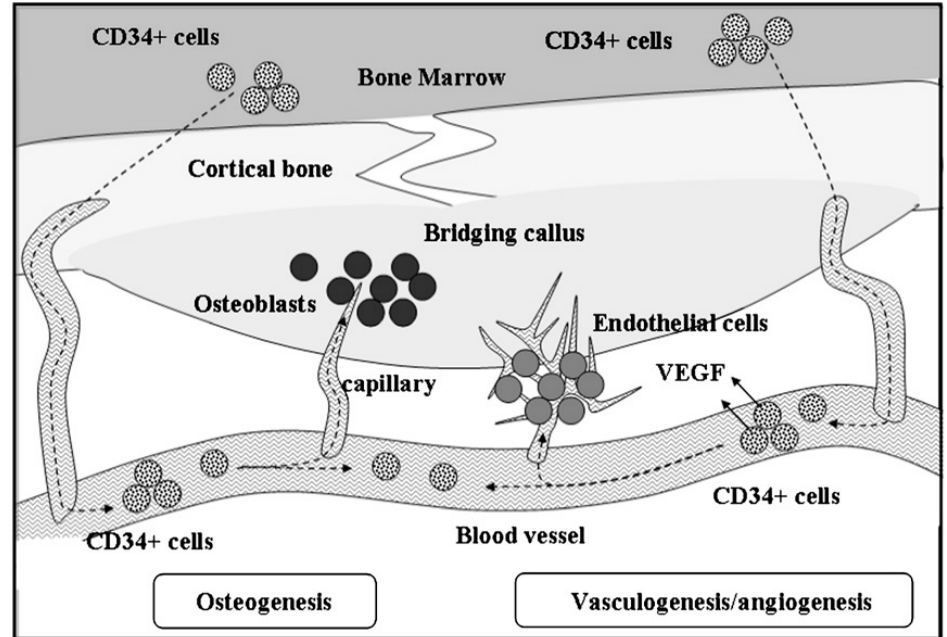
Figure 8. The systemic transplantation of human CD34+ cells/EPCs results in their recruitment to the fracture site. This causes a favorable environment for fracture healing by enhancing vasculogenesis/angiogenesis and osteogenesis, which leads to functional recovery from the fracture. With permission from Reference [262] .